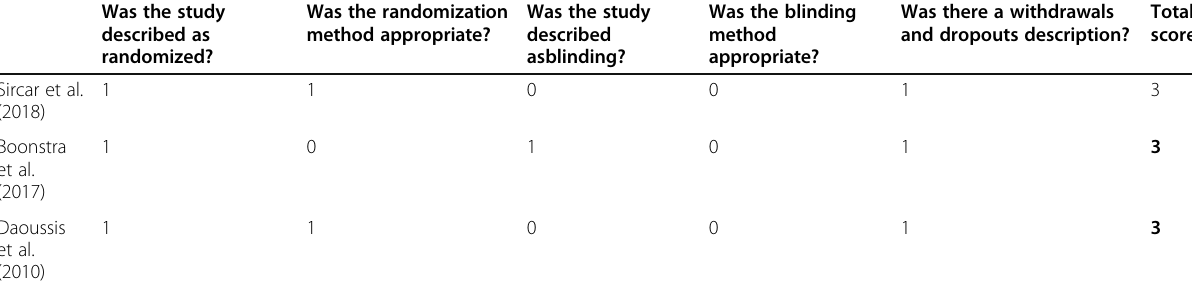
Table 2 Methodological design evaluation of the RCTs according to the JADAD scale (2005), classified in descending order Was the study described as